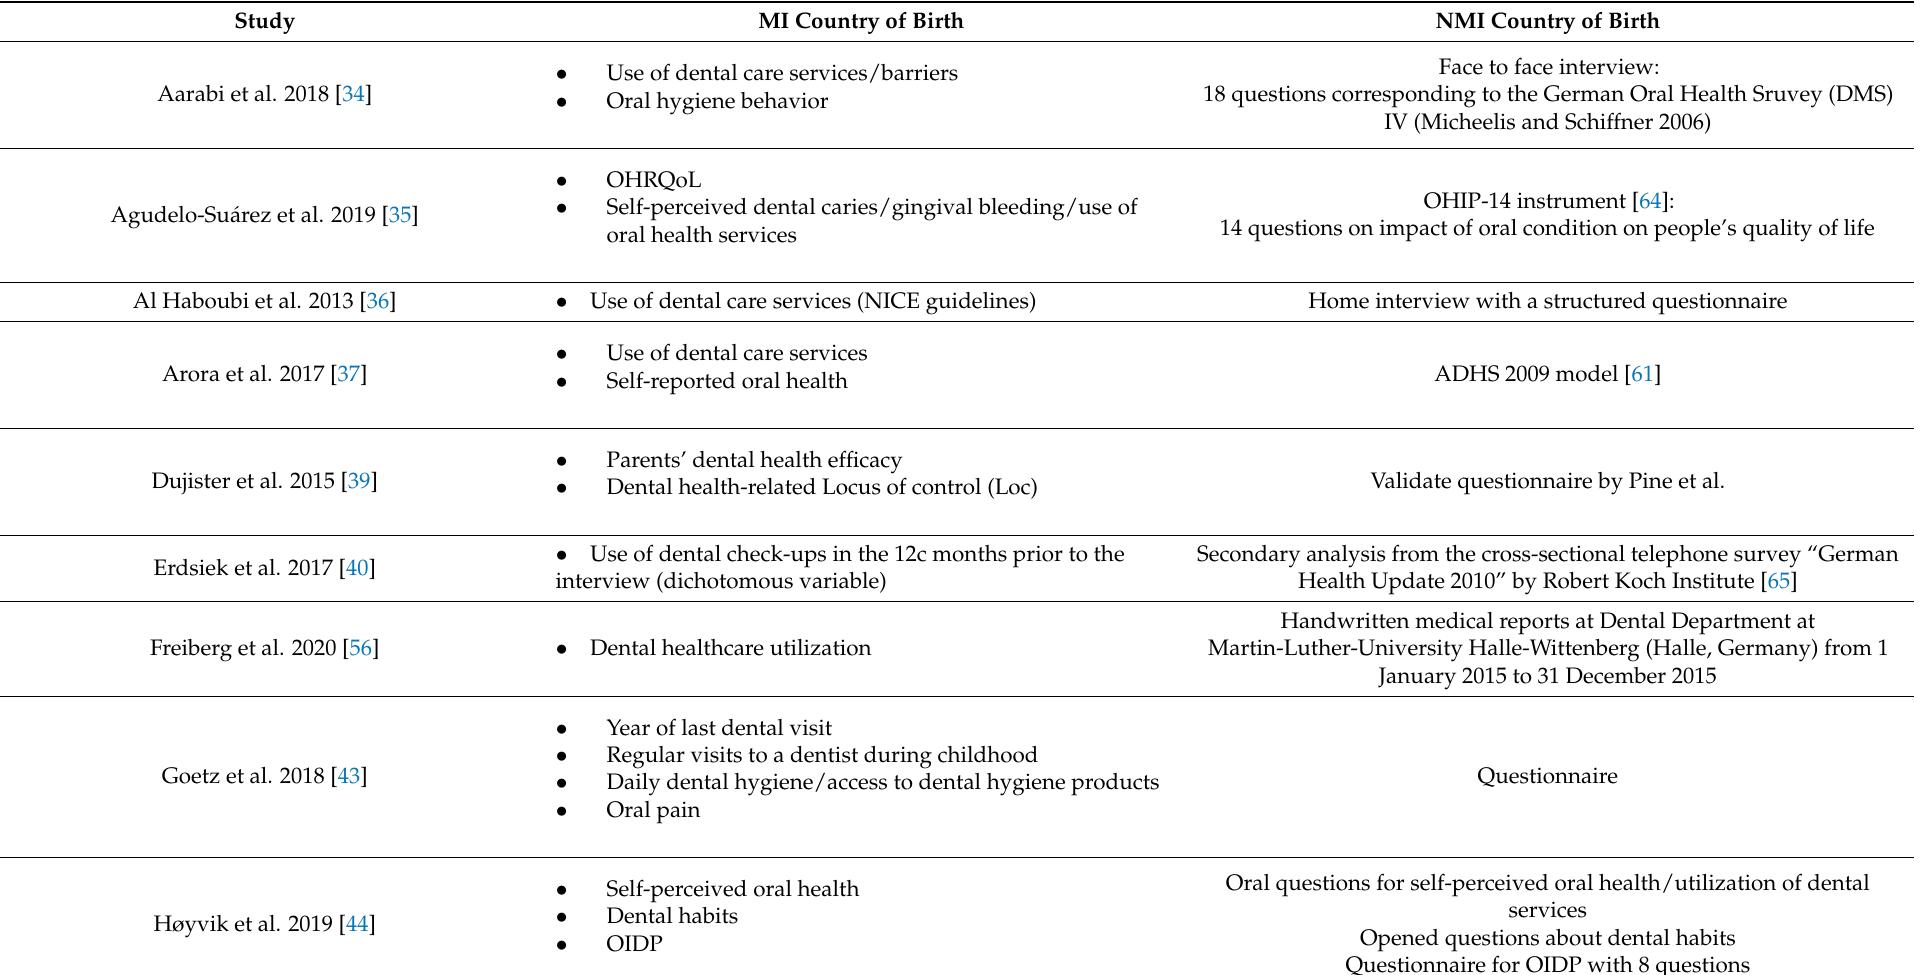
Table 7. Qualitative oral health indicators and data collection of the included